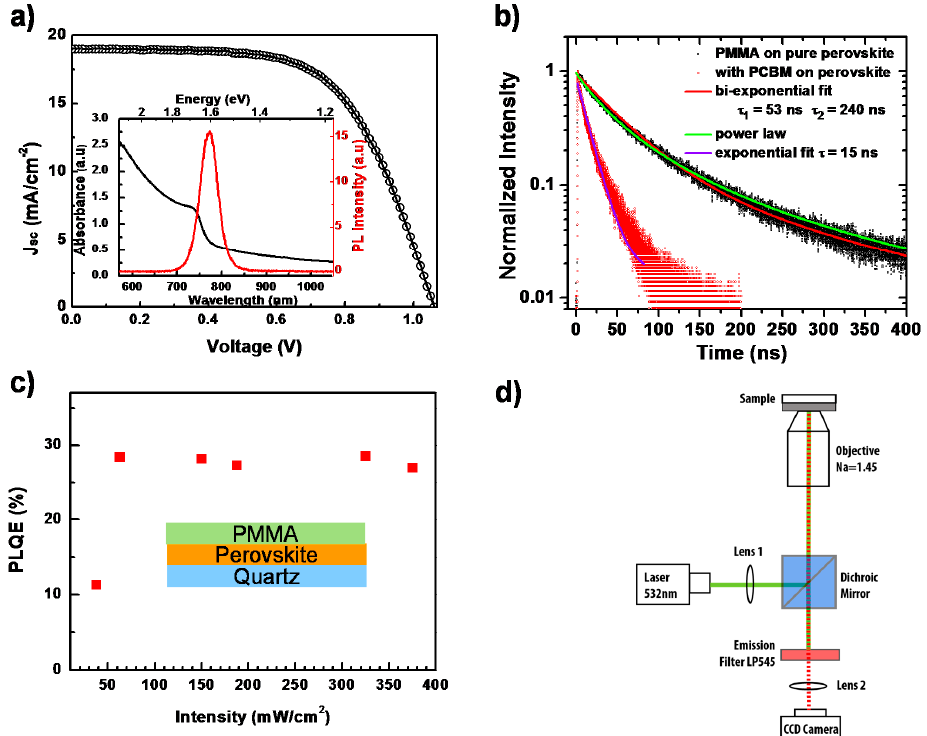
Figure 2. ( a ) Light current-voltage ( J–V ) curve measurement of a perovskite solar cell. The inset shows the photoluminescence (PL) and UV-VIS absorption spectra of a perovskite film; ( b ) Time-resolved photoluminescence measurement on a perovskite film with (red dots) and without (black dots) a PCBM quencher layer, together with fit lines; ( c ) Photoluminescence quantum efficiency (PLQE) of a perovskite thin film as a function of laser intensity. The inset shows the schematic of the device; ( d ) Schematic diagram of the PL imaging microscope.